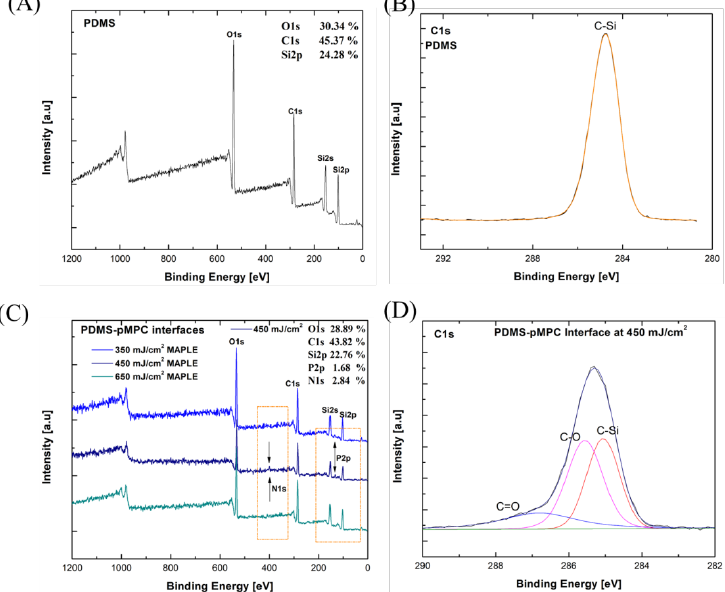
Figure 6. XPS analysis of PDMS interface: ( A ) XPS full spectra (black survey), ( B ) C1s high resolution spectra with ( C ) XPS full spectra (coloured survey) of PDMS – pMPC interfaces deposited by MAPLE method at different laser fluences, and ( D ) C1s spectra of PDMS – pMPC interface at 450 mJ/cm 2 .